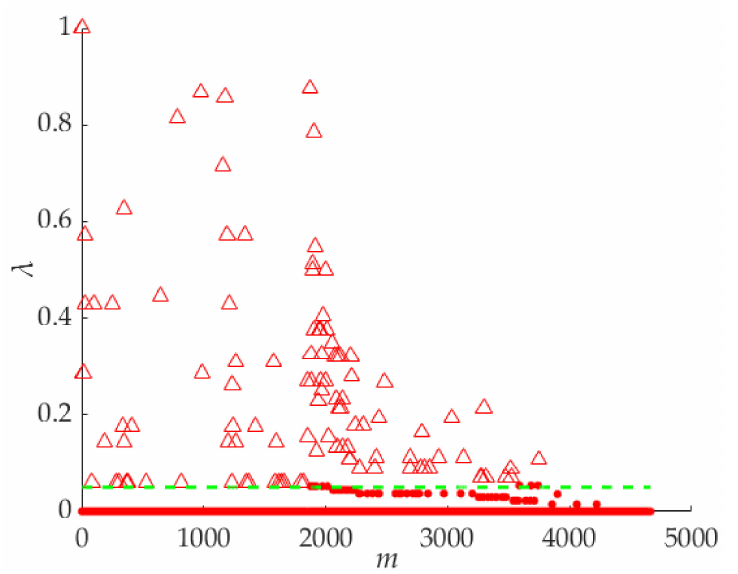
Figure 7. Extracting the cluster centers by λ . The triangle symbols are the center points, and the red dots are the other